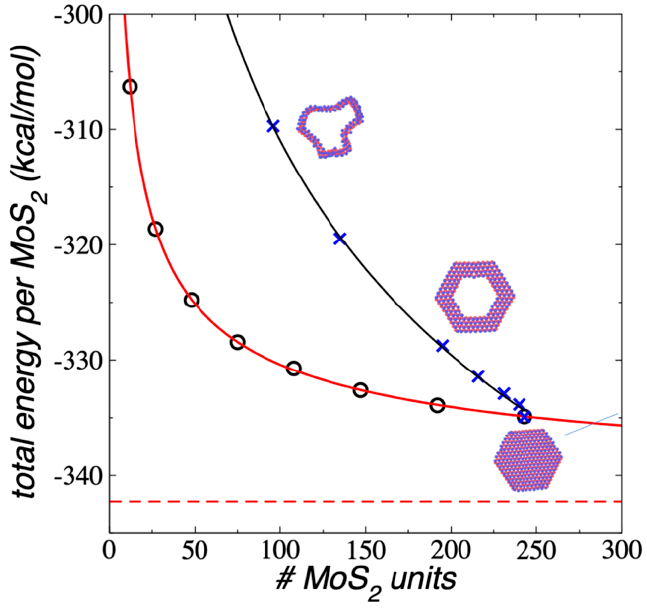
Figure 10. E #MoS2 of ring-like 1L flakes (blue crosses) as a function of the number of MoS 2 units, under vacuum and NVT conditions at 298.15 K. The black line represents a fitting to a power function on the total number of MoS 2 units. Black circles, and red lines represent the values and fittings of 1L flakes reported in Figure 2. The inset snapshots corresponded to the equilibrated conformations of the ring-like 1L Mo 96 S 192 flake (top), Mo 147 S 294 flake (center), and the full-covered flake Mo 243 S 486 (bottom). Blue and red spheres represent Mo and S atoms, respectively.